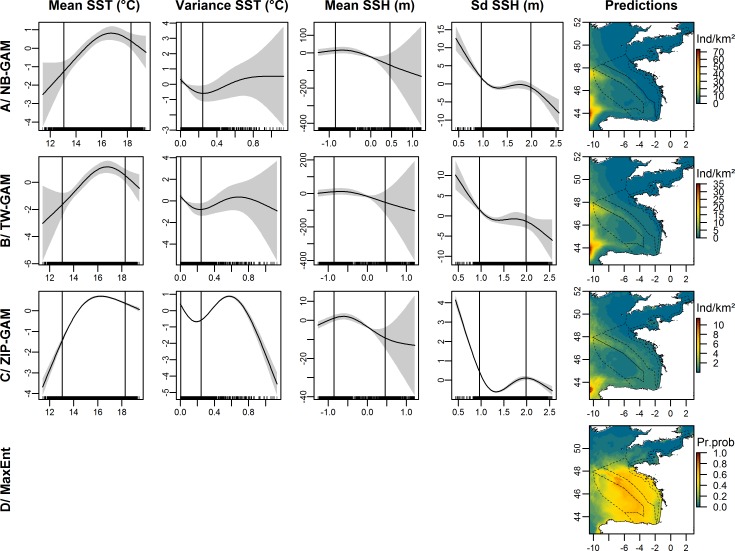
Estimated smooth functions for the selected covariates and predicted distribution of dolphins in individuals.km-2 (Ind/km2) for each presence-absence model and in presence probabilities (Pr.prob) for the Maxent model.The solid line in each plot is the estimated smooth function, and the shaded regions represent the approximate 95% confidence intervals. The y-axis indicates the number of individuals on a log scale, and a zero indicates no effect of the covariate. The best model fits are between the vertical lines indicating the 10th and 90th quantiles of the data. The dotted lines represent the bathymetric strata of the survey area. The white areas on certain maps represent the absence of predictions beyond the range of covariates used in fitted models.